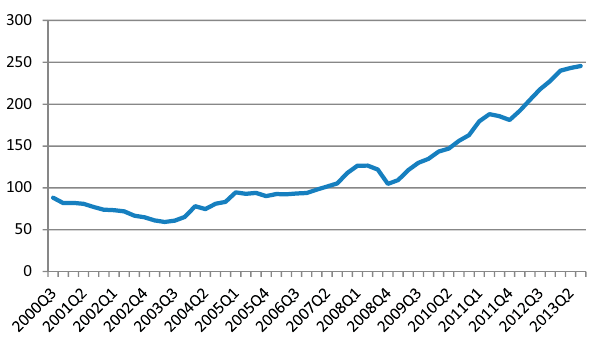
fig. 1. Hong Kong average property price index (for private residential housing) Source : Hong Kong monthly digest of statistics, by census and Statistics